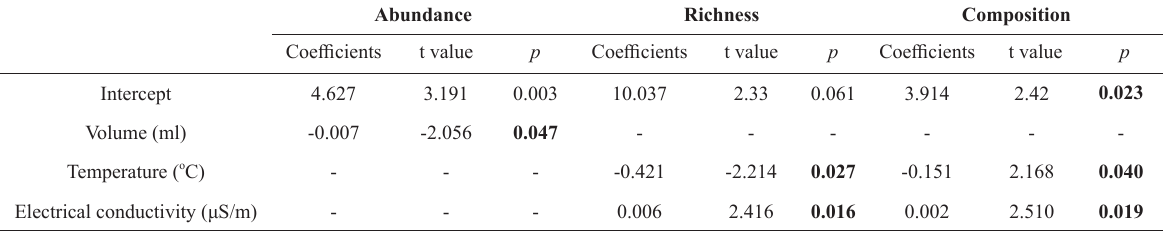
Results of the multiple regression modeling the abundance, richness, and composition (Non-Metric Multidimensional Scaling – Axis 1) of Ceratopogonidae from an urban forest fragment in Central Amazon. In bold, significant p -values. Abundance